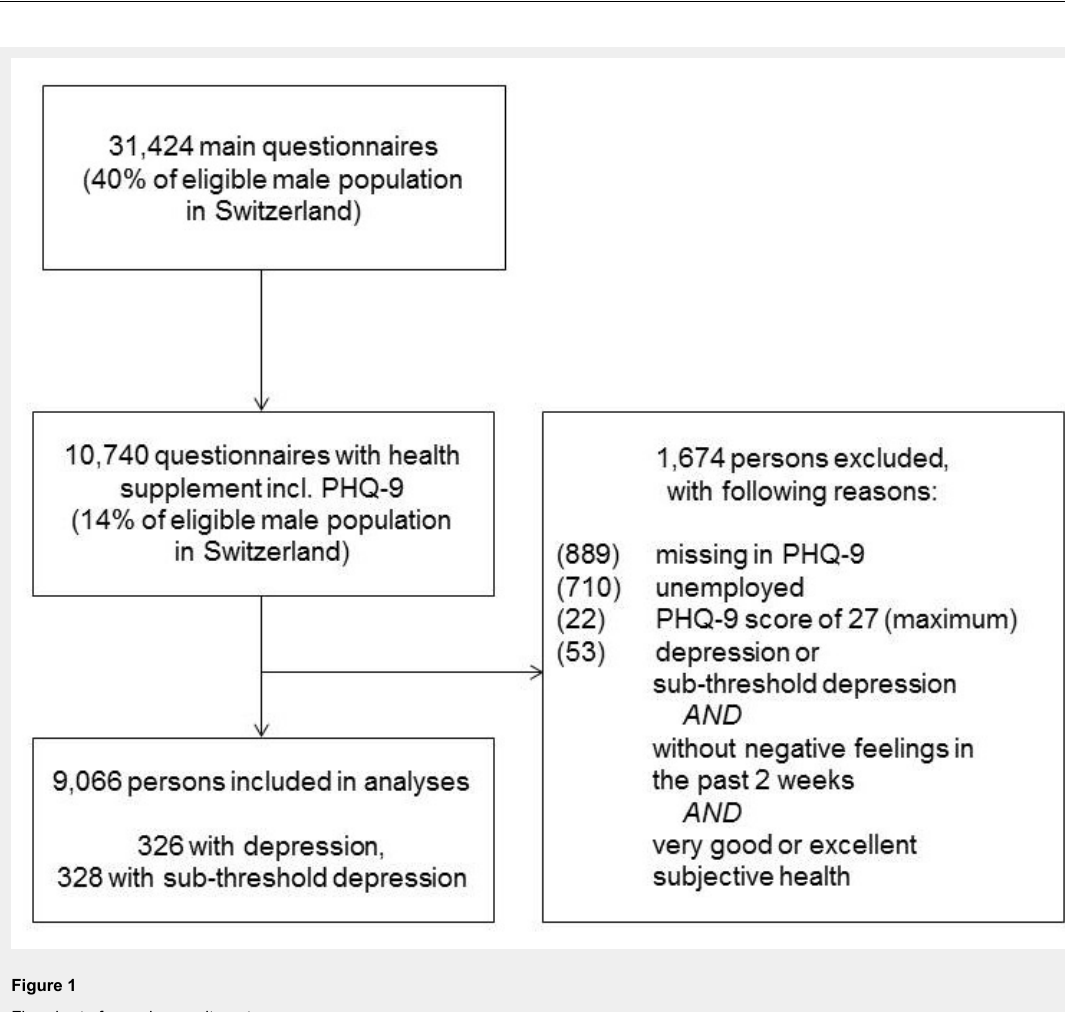
Figure 1 Flowchart of sample